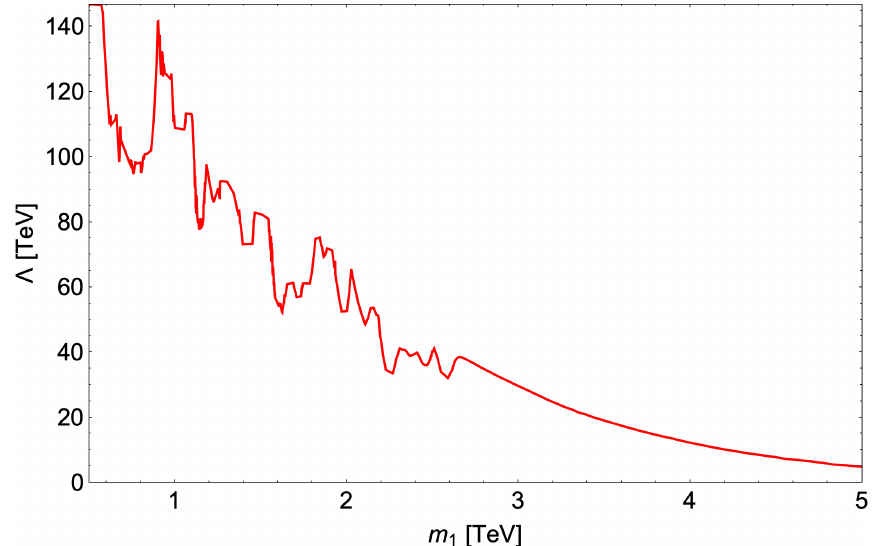
Figure 7 . Limit on Λ as a function of m 1 inferred from the ATLAS di-photon resonance